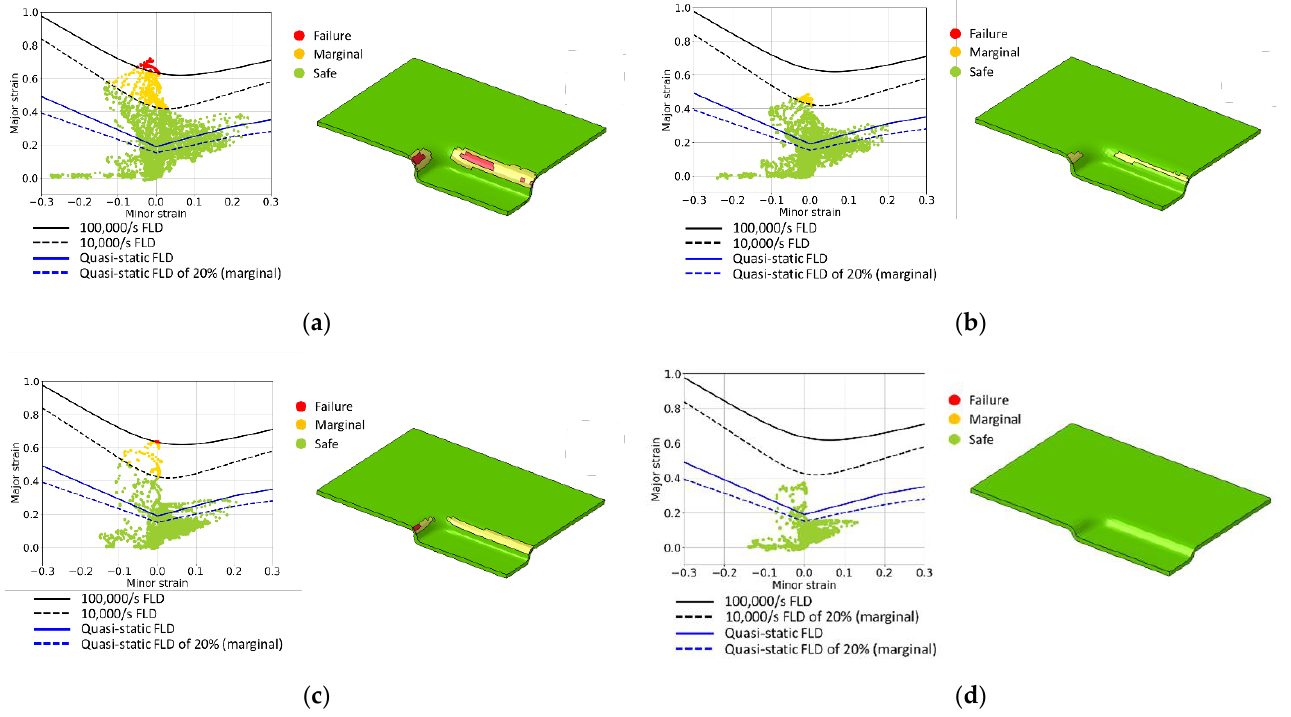
Figure 9. FLD and formability evaluation of EMF for ( a ) CASE 1, ( b ) CASE 2, ( c ) CASE 3, and ( d ) CASE 4.